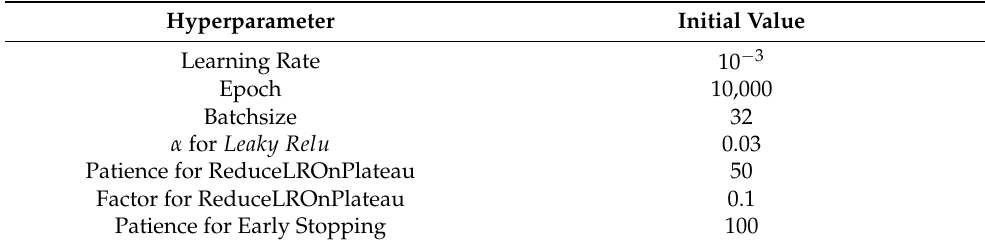
Table 1. Hyperparameters in the Training